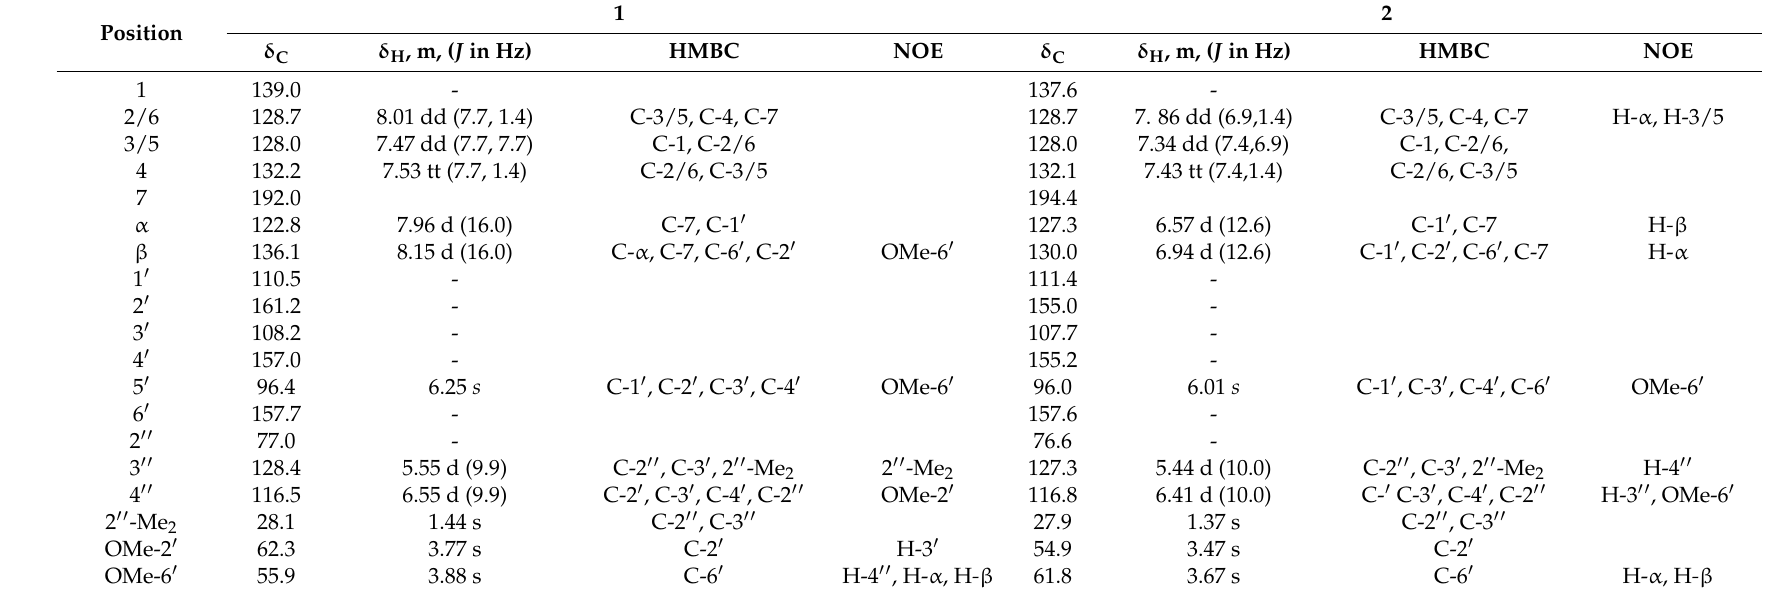
Table 1. 1 H (800 MHz) and 13 C (200 MHz) NMR data for aequichalcone A ( 1 ) and B ( 2 ) acquired in CDCl 3 at 25 ◦